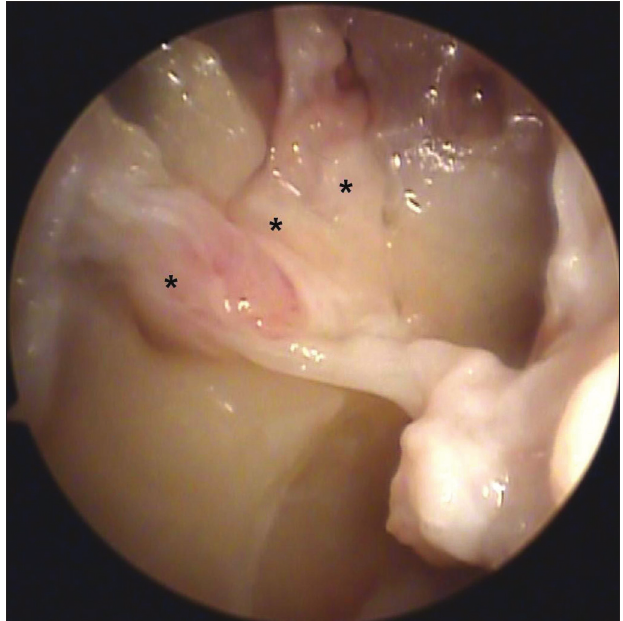
Figura 1. Fotografia da fossa nasal direita exibindo três ramos arteriais (*) emergindo do forame esfenopalatino.